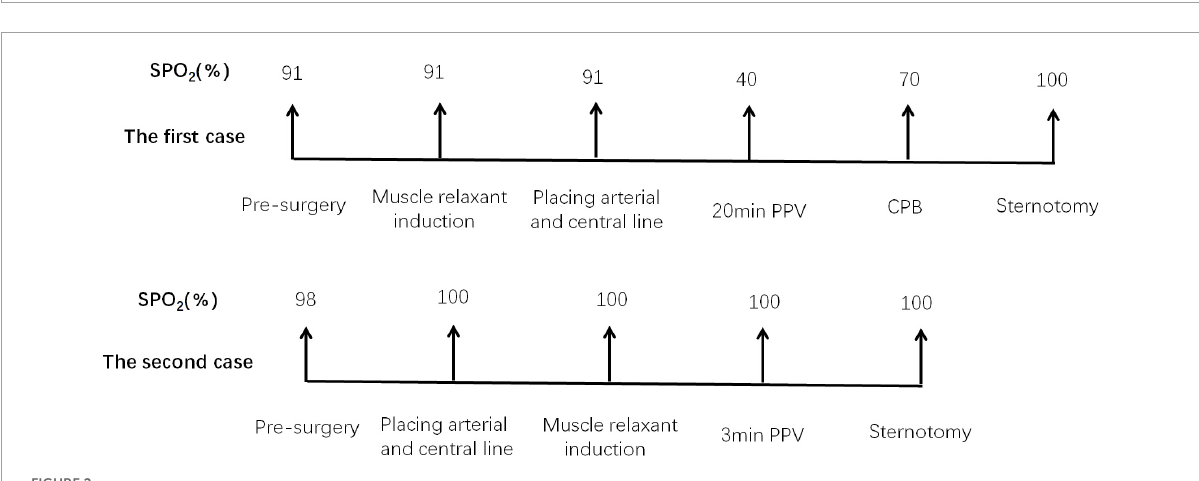
FIGURE2 Summary of the entire process. PPV, positive-pressure ventilation; CPB, cardiopulmonary